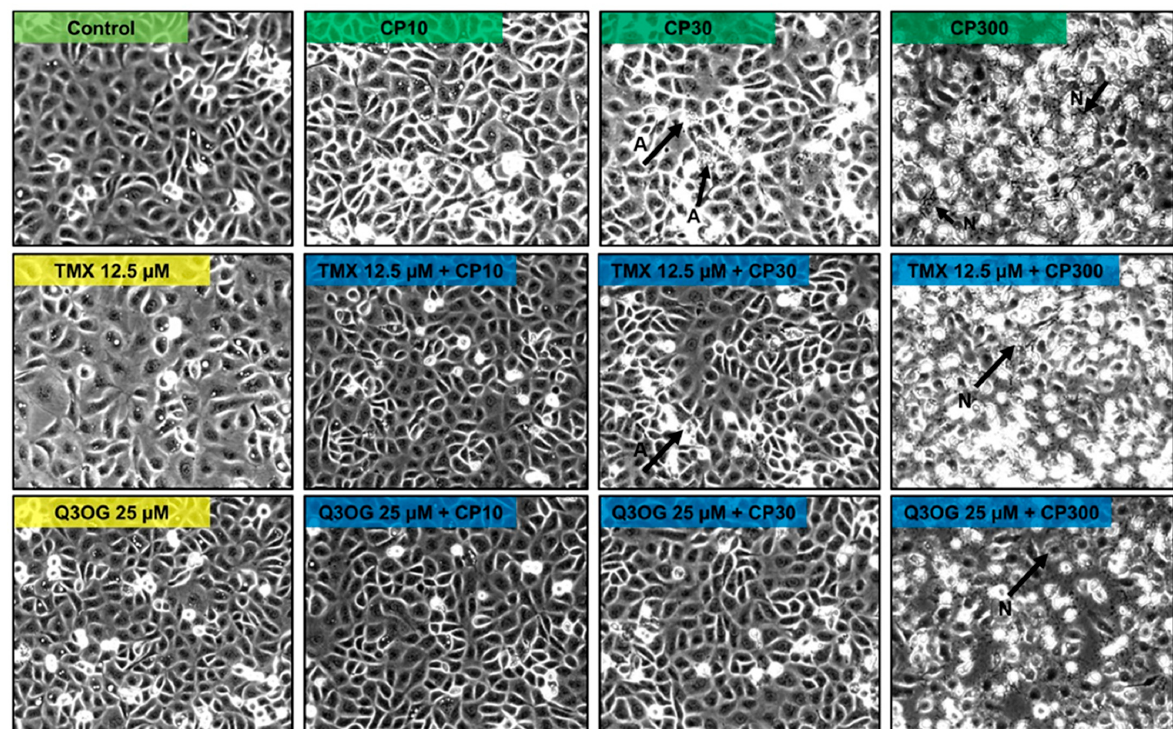
Figure 5. Representative images of HK-2 cells taken under the light microscope (10× magnification). First line: cells without treatment (Control) and treated with cisplatin 10 (CP10), 30 (CP30) and 300 (CP300) μ M for 18 h. Second line: cells treated with tamarixetin (TMX) at a concentration of 12.5 μ M for 24 h, and cells pretreated with TMX 12.5 μ M for 6 h and subsequently cotreated 18 h with TMX 12.5 μ M and CP10, CP30 and CP300, respectively. Third line: cells treated with quercetin 3- O -glu-